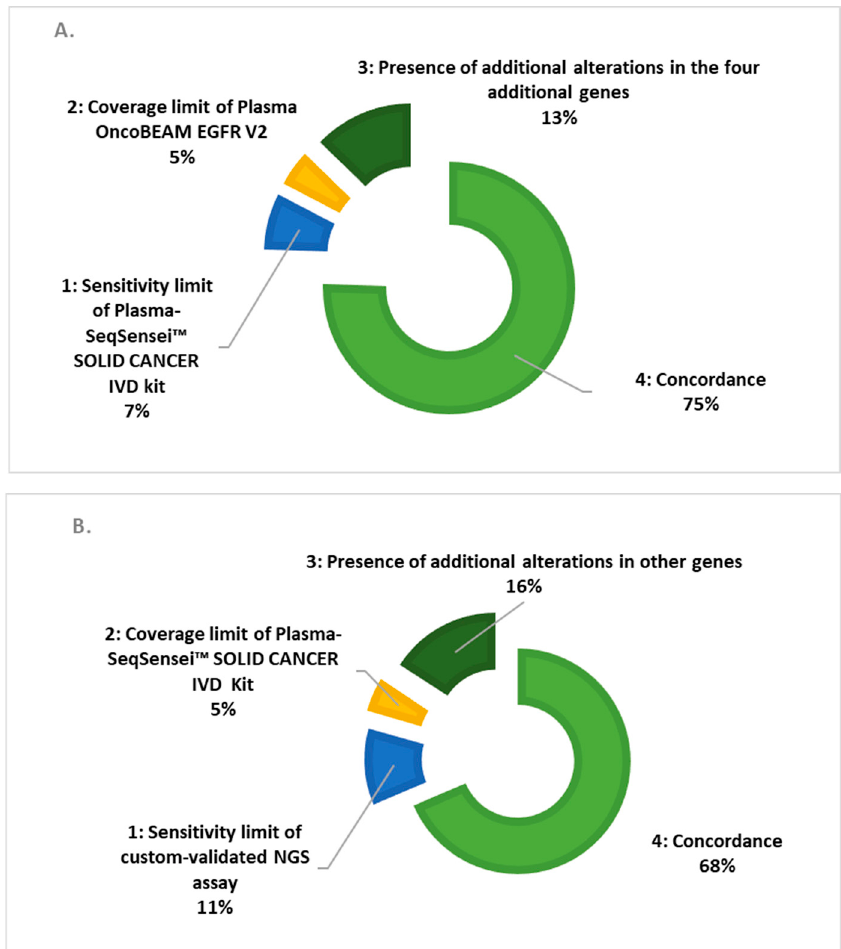
Figure 1. Cases of discordance (%) in the three assays: ( A ) Comparison of the Plasma OncoBEAM™ EGFR V2 assay vs. the Plasma-SeqSensei™ SOLID CANCER IVD assay; ( B ) comparison of our custom validated NGS assay vs. the Plasma-SeqSensei™ SOLID CANCER IVD assay .